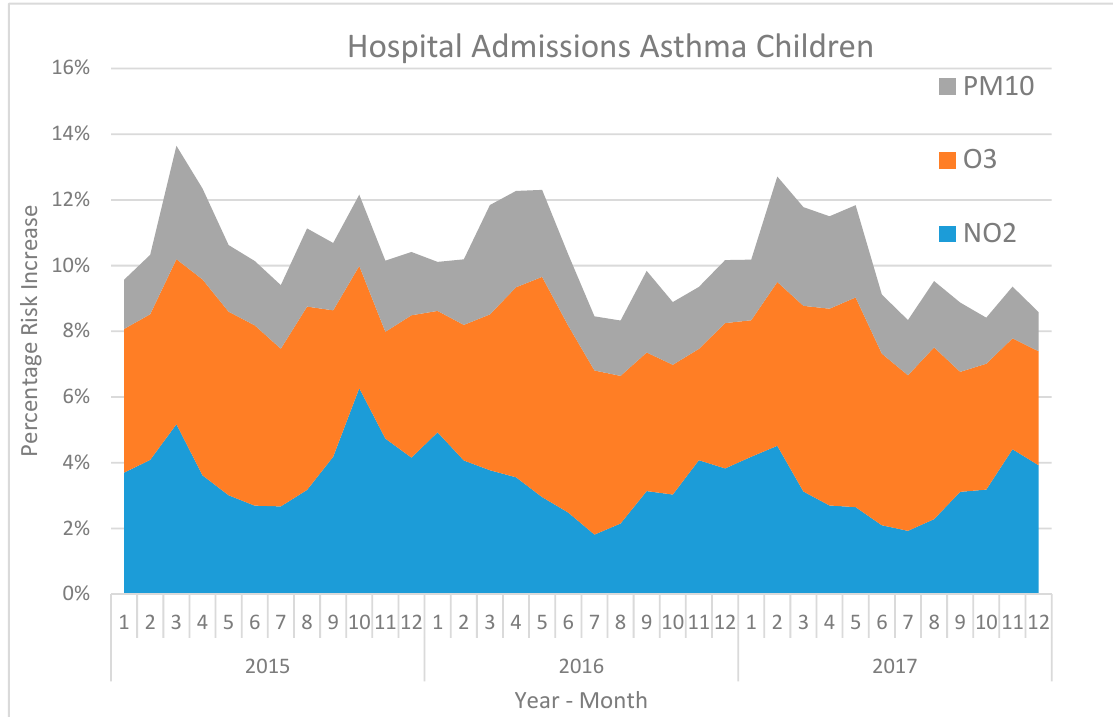
Figure 5. The calculated average monthly percentage risk increase associated with NO 2 , O 3 , and PM 10 for hospital admissions for asthma in children in Stockholm during 2015–2017 based on meta-coefficients [8].